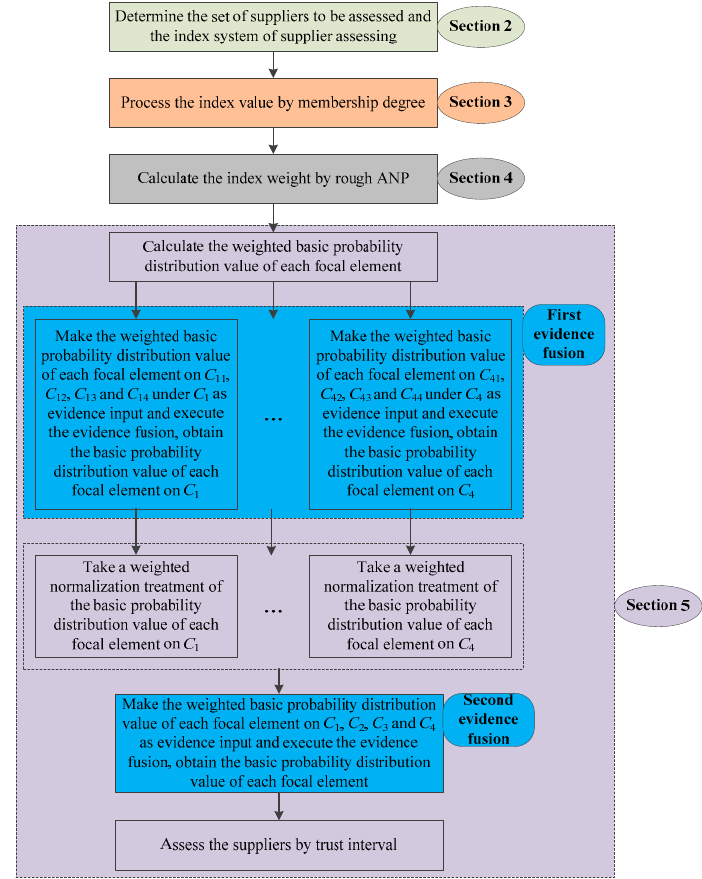
Figure 3. The green supplier assessment procedure.